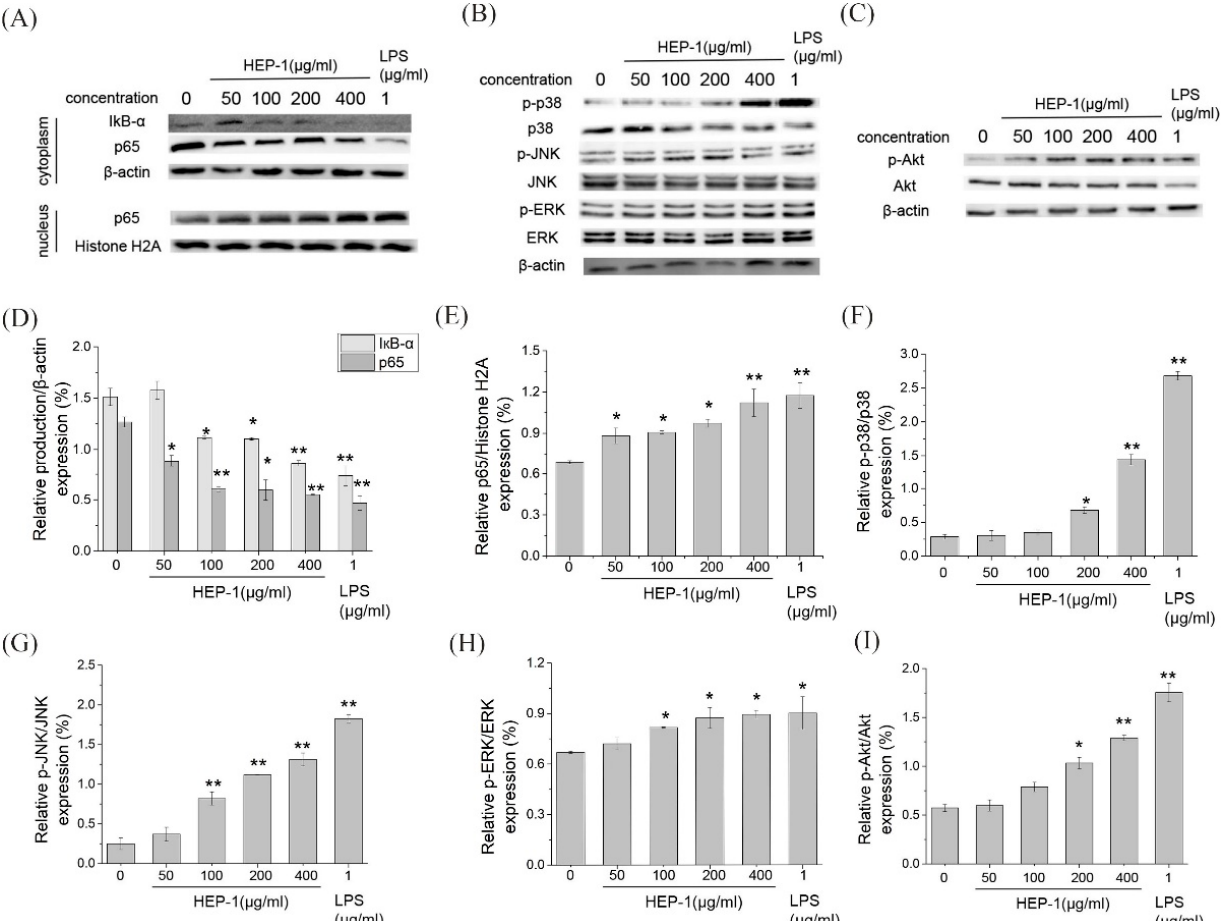
Figure 4. Immunomodulatory activities of HEP-1 detected by RAW264.7/Caco-2 cells model. Effect of HEP-1 on cytoplasm/nuclear ( A ) NF- κ B (p65), ( B ) MAPK, ( C ) PI3K/Akt signaling pathways. The quantified expression of ( D ) I κ B- α or p65/ β -action on cytoplasm and ( E ) p65/Histone H2A on nucleus. The quantified expression of ( F ) p-P38/P38, ( G ) p-JNK/JNK, ( H ) p-ERK/ERK. The quantified expression of p-Akt/Akt ( I ). Cells were incubated with HEP-1 (0, 50, 100, 200, 400 µ g/mL) or LPS (1 µ g/mL) for 3 h. Data are presented as mean ± SD ( n = 3). * p < 0.05, ** p <0.01 compared with the CK group.